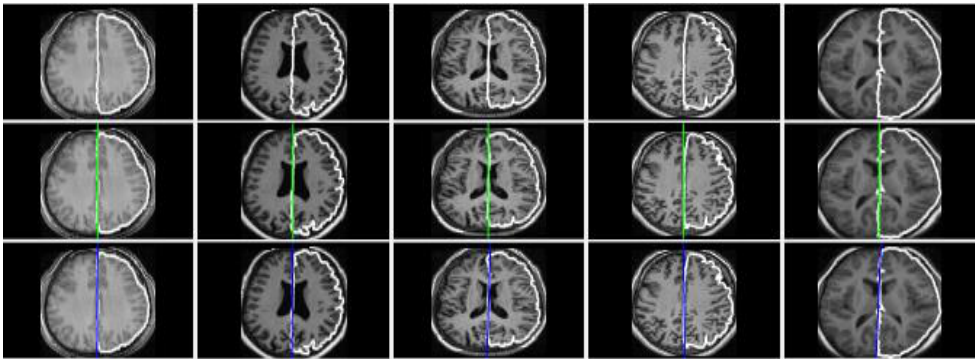
Figure 14. Visual comparison of the proposed algorithm with Ruppert et al. algorithm for extracting the symmetric axis (MSP) from real head volumes of the IBSR database [49]. First row, second row, and third row display the input images, the proposed algorithm results, and Ruppert et al. algorithm results, respectively.